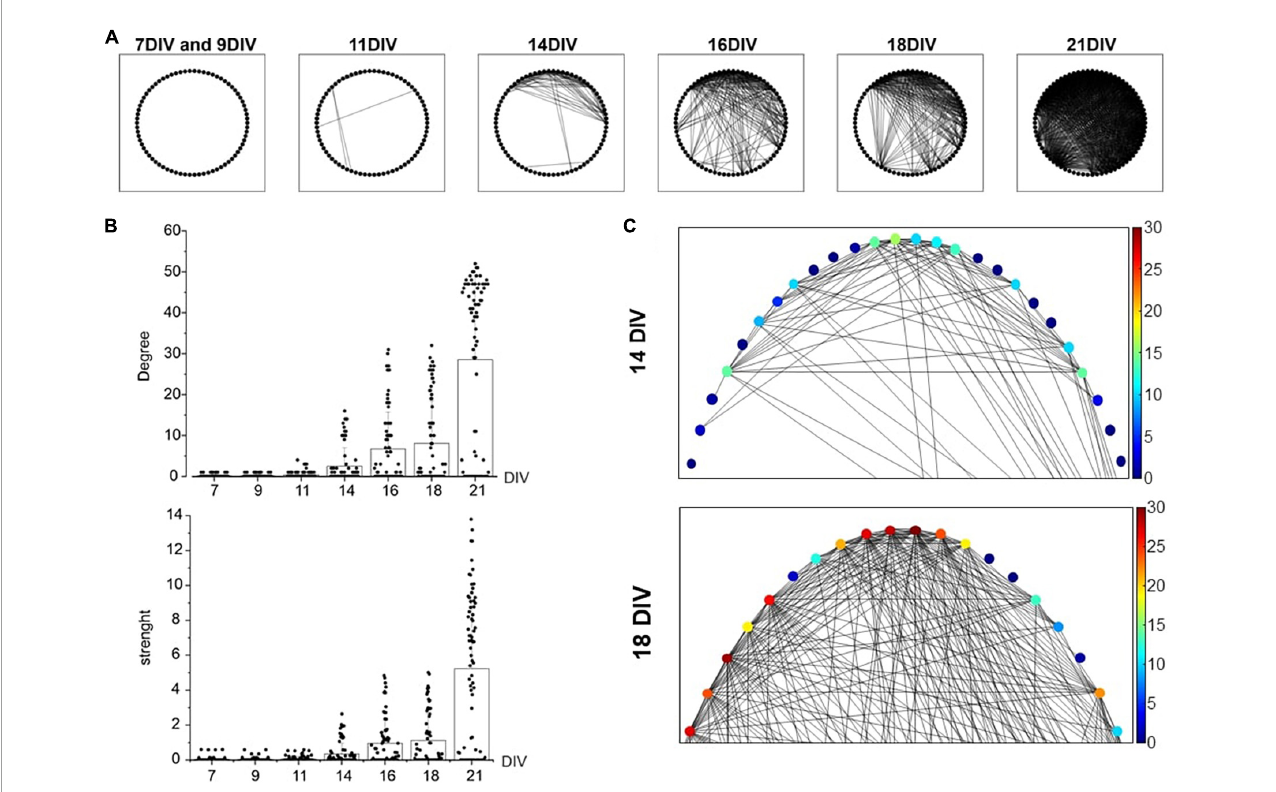
FIGURE3 Cross-correlation increase evaluated through the Maximum of the Absolute Value of the Cross-Correlation (MAVCC). (A) The graphs for the adjacency matrixes of the culture for different days in vitro (DIV) is shown: each node (indicated as a black circle) represents a neuron and each edge (segment) represents the cross-correlation between the two neurons (MAVCC > 0.1). (B) Bar plots show the node degree and strength of each neuron. (C) An enlargement of the adjacency matrix reported in panel (A) . The algorithm has been applied to a representative microelectrode arrays (MEA), in which 37 active channels have been identified. Each channel detected the activity of 2 neurons (thus, N = 74 neurons were recognized). In order to explore possible functional connections between neurons, all possible couples were cross-correlated. Statistical differences ( p -value < 0.01) are found with